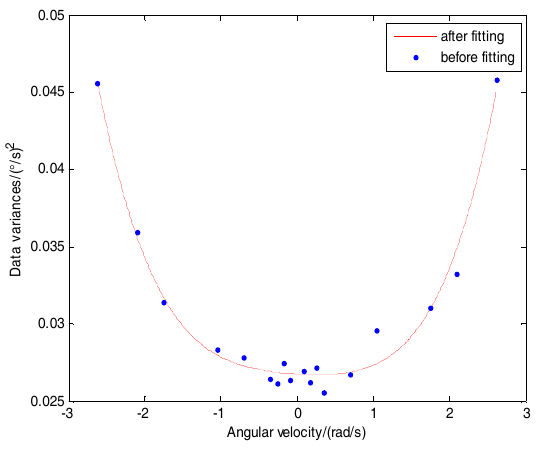
Figure 1. Raw data variance fitting.